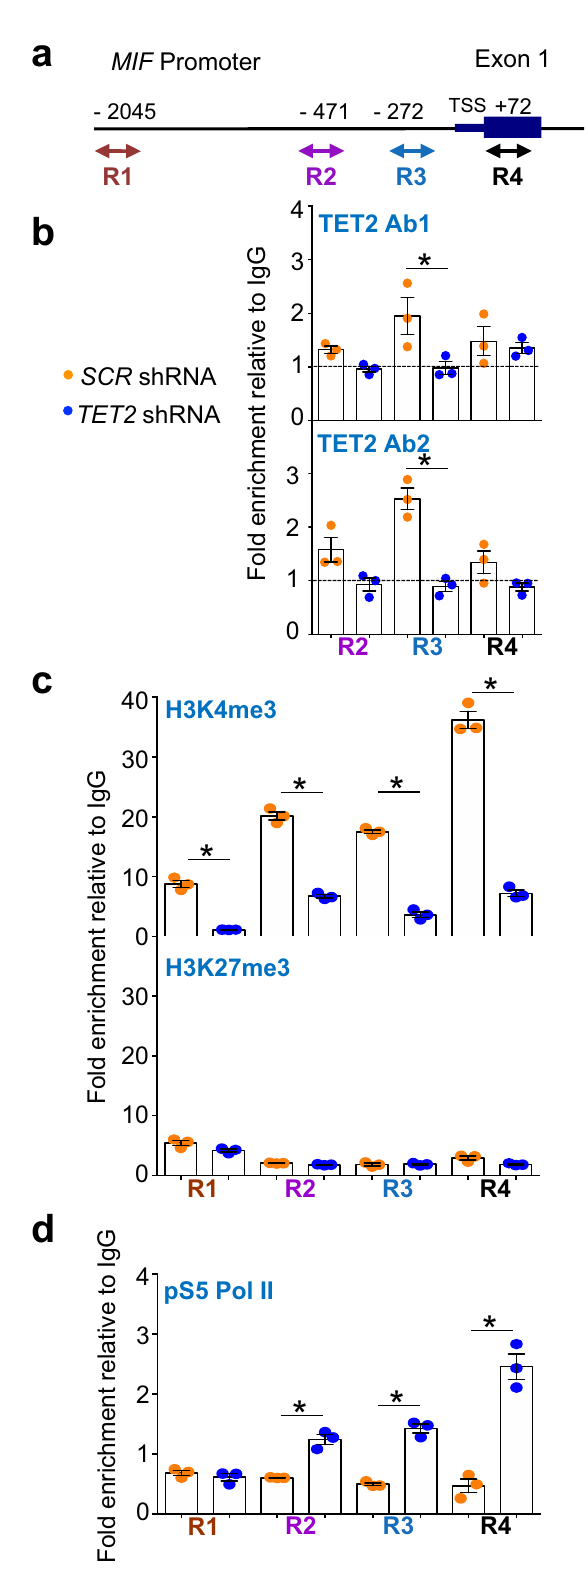
Fig. 3 TET2 binds to the proximal promoter of MIF . a Schematic representation of MIF gene promoter. Quantitative ChIP-PCR analyses were performed in kasumi-1 cells infected by SCR (yellow) or TET2 (blue) shRNAs by using a set of primers targeting regions located in distal (R1), intermediate (R2), proximal (R3) promoter, and in exon 1, closed to the TSS (R4). b TET2-associated DNA was immunoprecipitated with either C2 (TET2 Ab1 upper panel) or sc-136926 (TET2 Ab2, lower panel) antibodies. with DNA immunoprecipitation. d RNA polymerase II phosphorylated on Results are expressed as fold enrichment relative to